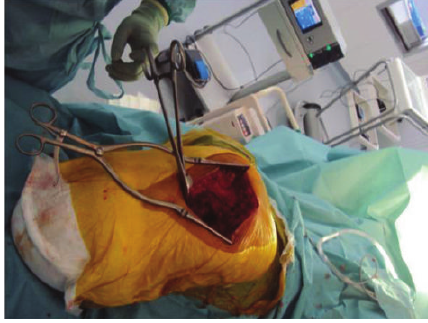
Figure 4: A bone forceps placed 5 cm under the trochanter.